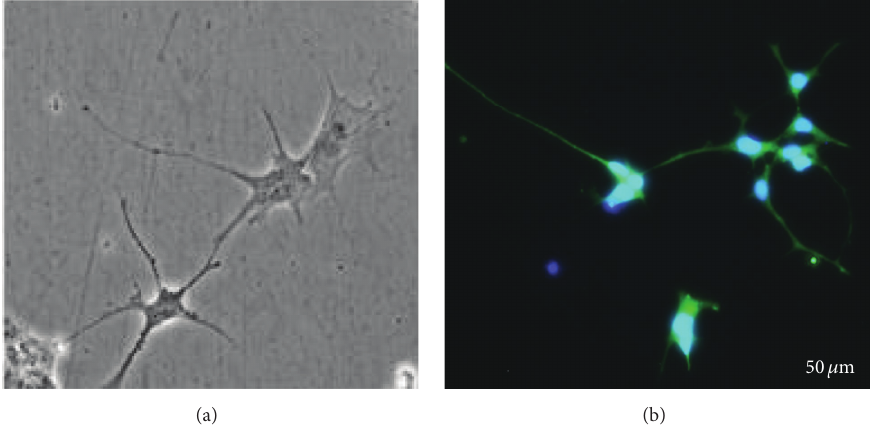
Figure 3: Microphotographs of footprint-free iPSC-derived astrocytes. (a) Phase contrast and (b) immunocytochemistry for GFAP 9 days after MACS sorting of mRNA iPSC-derived